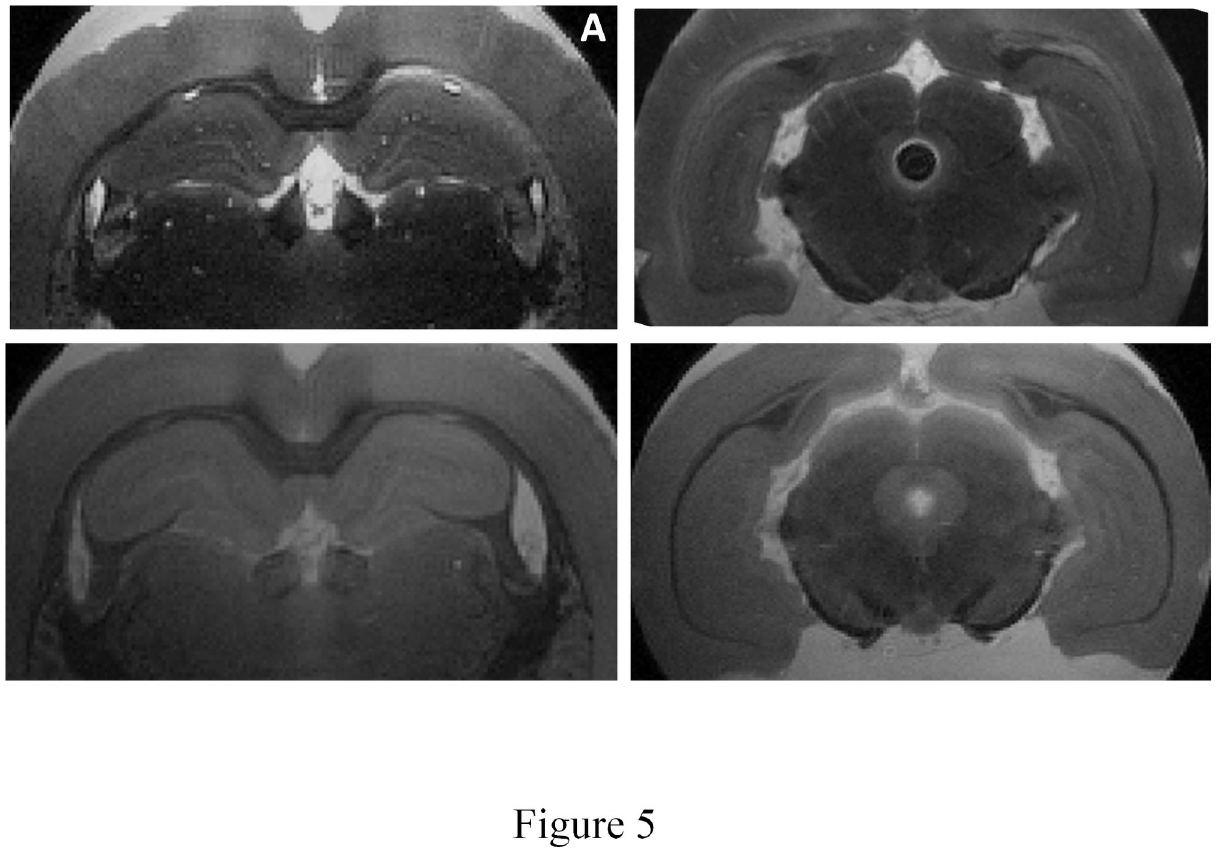
Figure 5. Hippocampal sub-layers visualization increased by MRI contrast agent. Comparison of MRI images without gadolinium ( below ) and after 70 min of passive staining ( above ) (A3) on dorsal hippocampus ( left ) and ventral hippocampus ( right ). The same number of layers can be seen with a better visualisation of the ventral hippocampus.